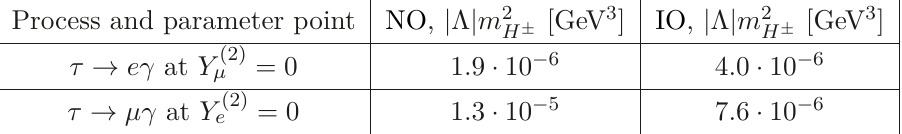
Λ m 2 for the current bounds on µ eγ by the MEG H ± | | → µγ or τ eγ , as in table 2. The bold values of the → → eγ allows the point with Y (2) τ = 0. →